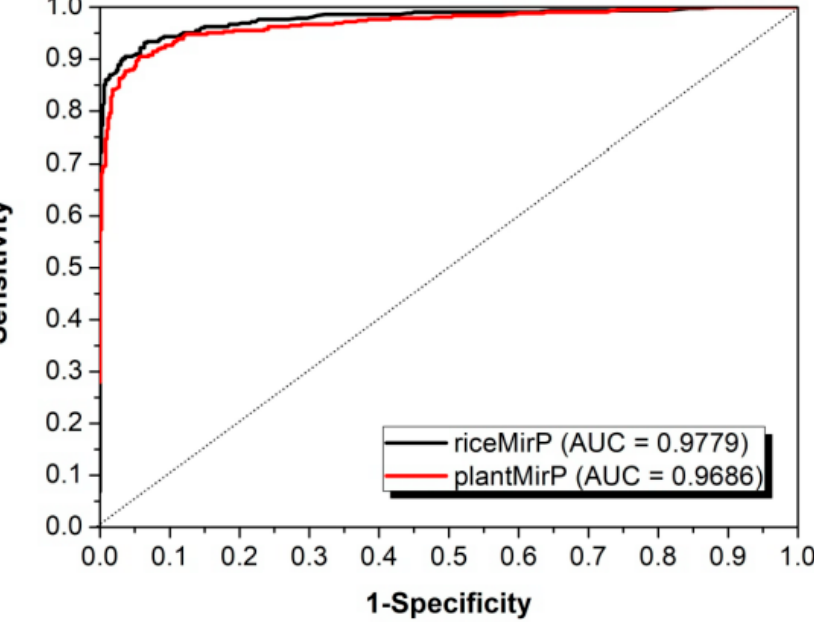
Figure 4. Comparison of riceMirP with plantMirP based on training dataset of riceMirP.